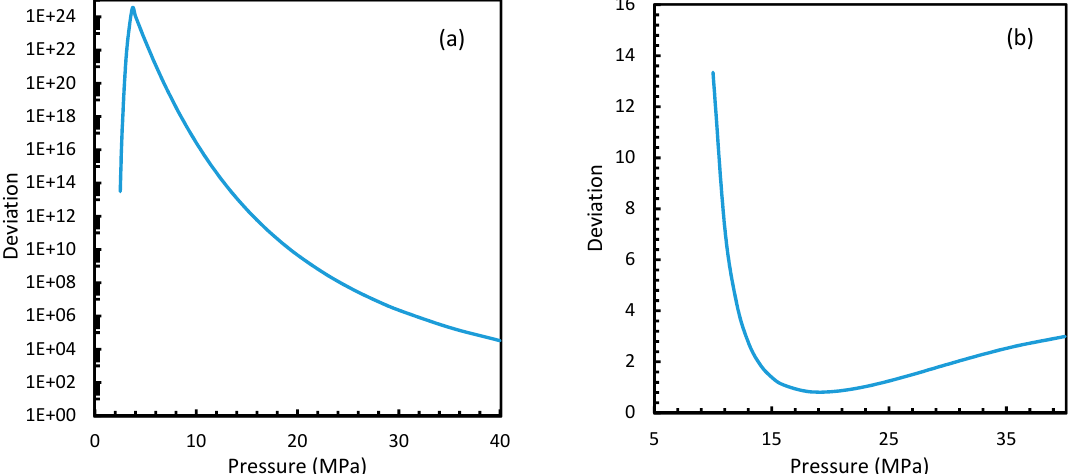
Figure 11. Profiles of deviations of nucleation rates of CO 2 ( a ) and CH 4 ( b ) under isobaric conditions with the reference temperature of 273.2 K, calculated through Case 6, from Case 2. The profiles show asymptotic curves, generally high deviations at lower pressure conditions that were dropped as the pressure increased. The deviations are immense for CO 2 nucleation when compared to CH 4 . For CH 4 , high deviations were observed near at low pressure or at unfavorable hydrate conditions.